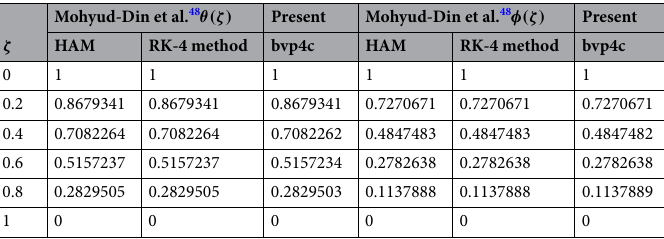
Table 5. Comparison of temperature and concentration profile of present analysis with Mohyud-Din et al. 48